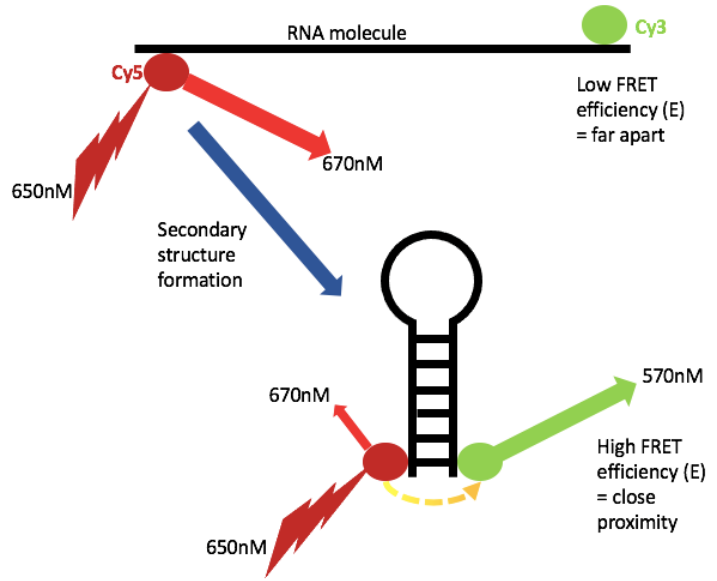
Figure 4. Principle of single molecule FRET (sm-FRET). sm-FRET relies upon the spatial proximity of a donor and acceptor dye. Where the dyes are far apart, there is little resonance energy transfer and a low E value; conversely, where the dyes are much closer to each other, transfer efficiency is greatly increased. Emission from the acceptor dye is a measure of proximity.